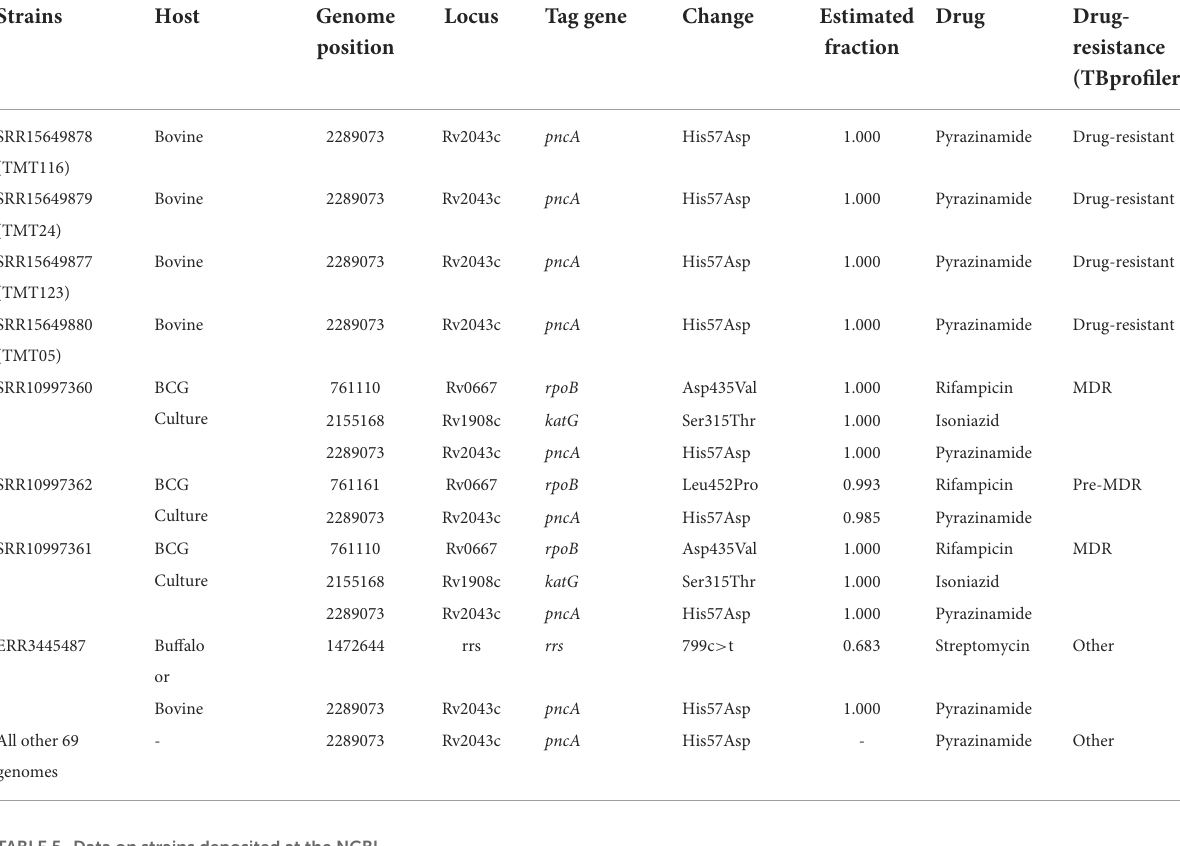
TABLE 4 Drug-resistant TBProfiler report.